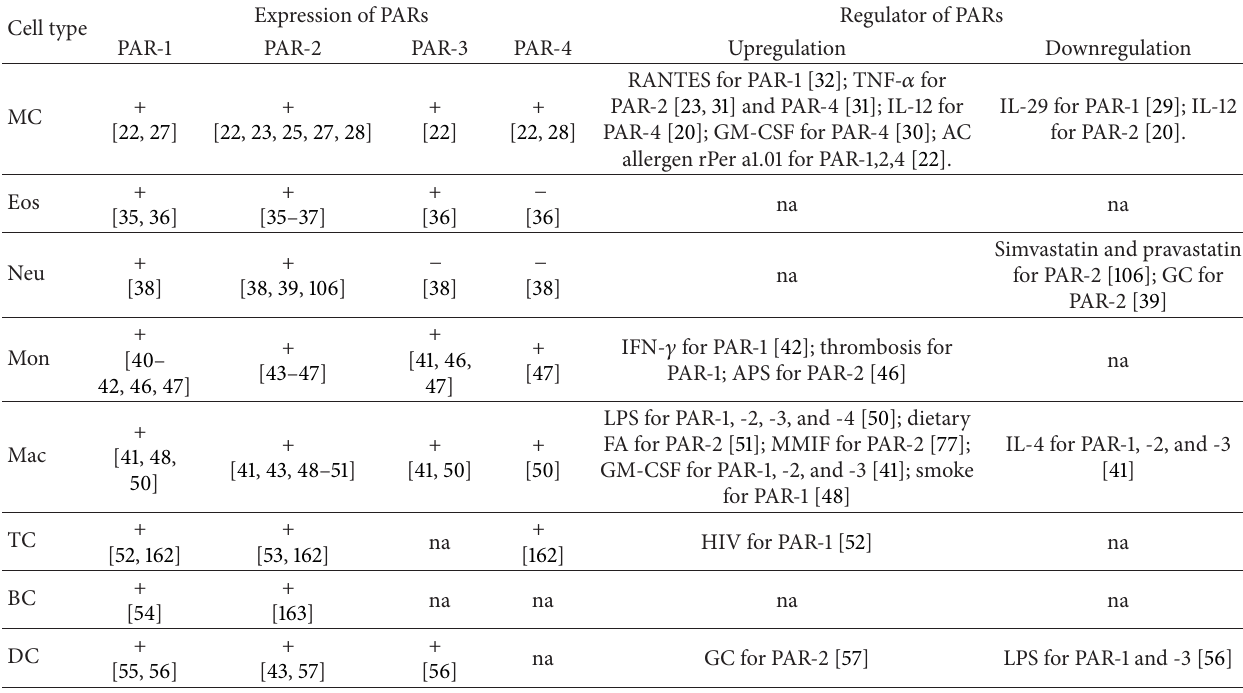
Table 1: Expression of protease activated receptors (PARs) on inflammatory